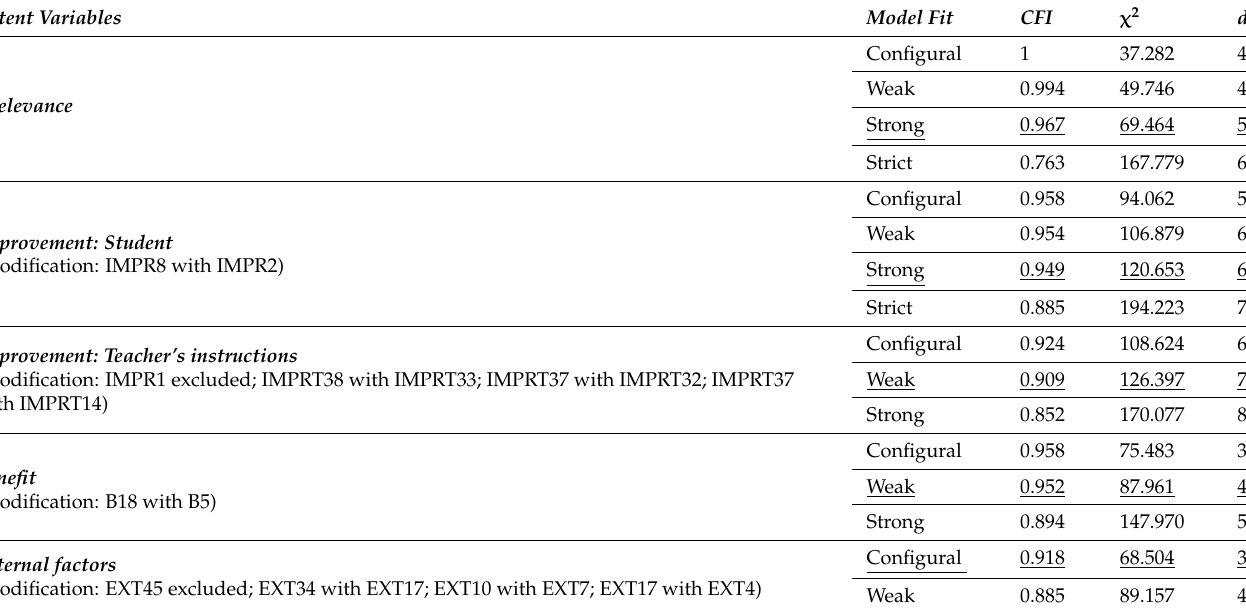
Table 1. Configural invariance modifications and accepted model